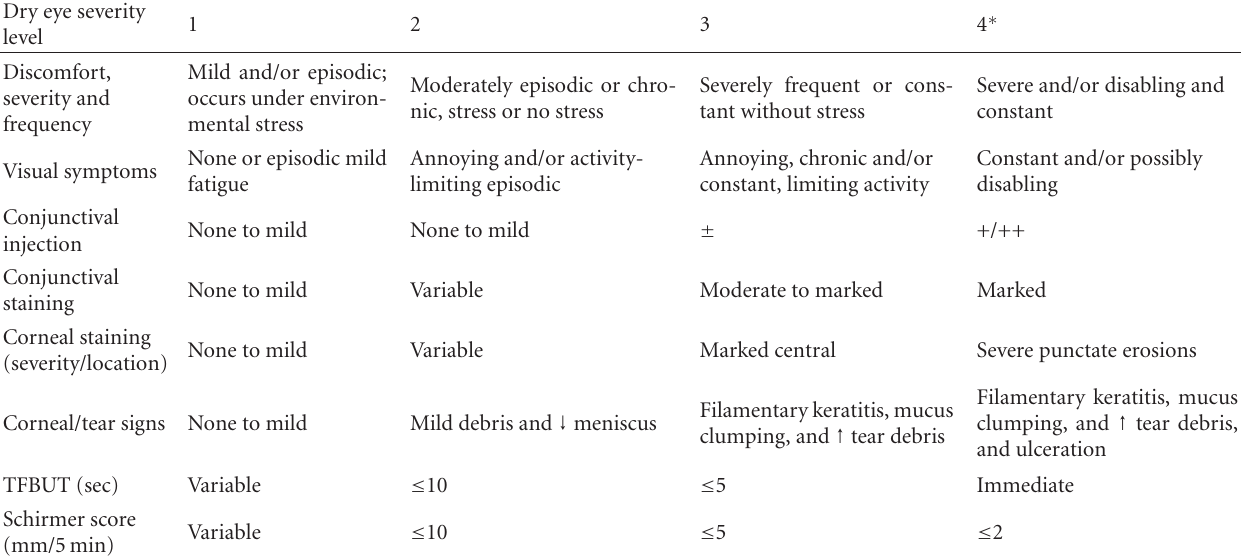
Table 1: Dry eye severity grading